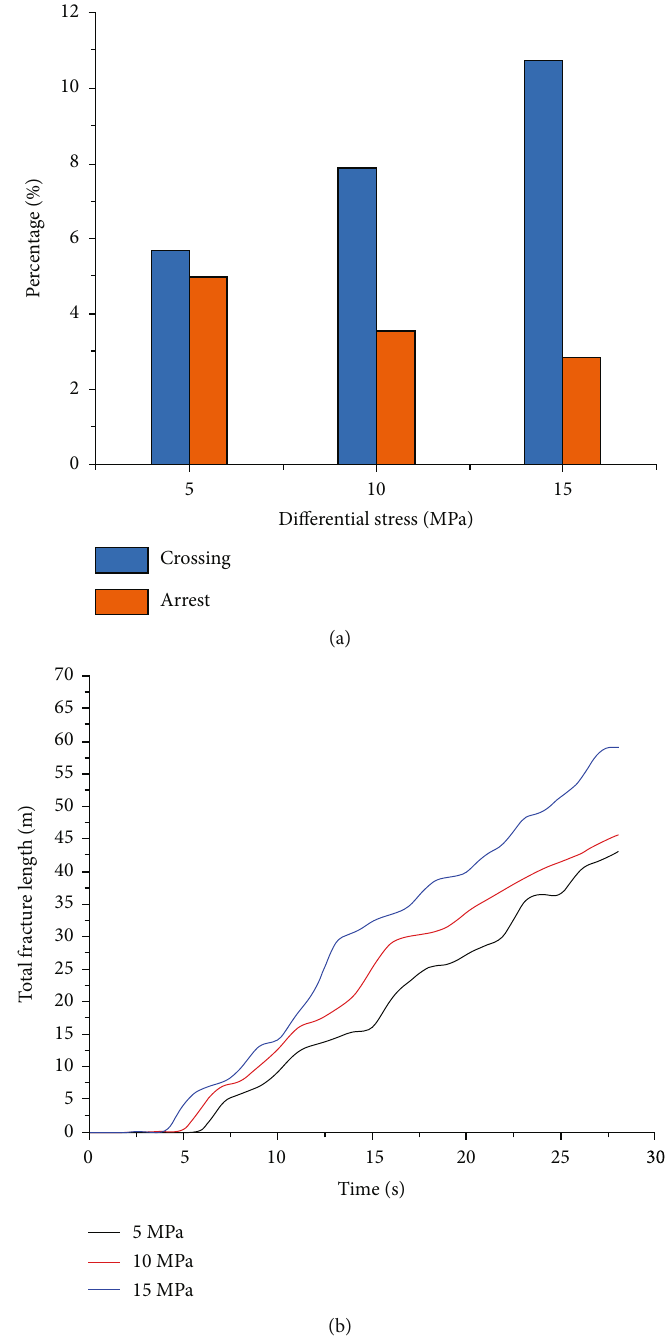
Figure 11: (a) Numbers of events that hydraulic fractures are crossing and arrested by natural fractures with di ff erent horizontal stress di ff erences. (b) Fracture propagation length for varying stress di ff